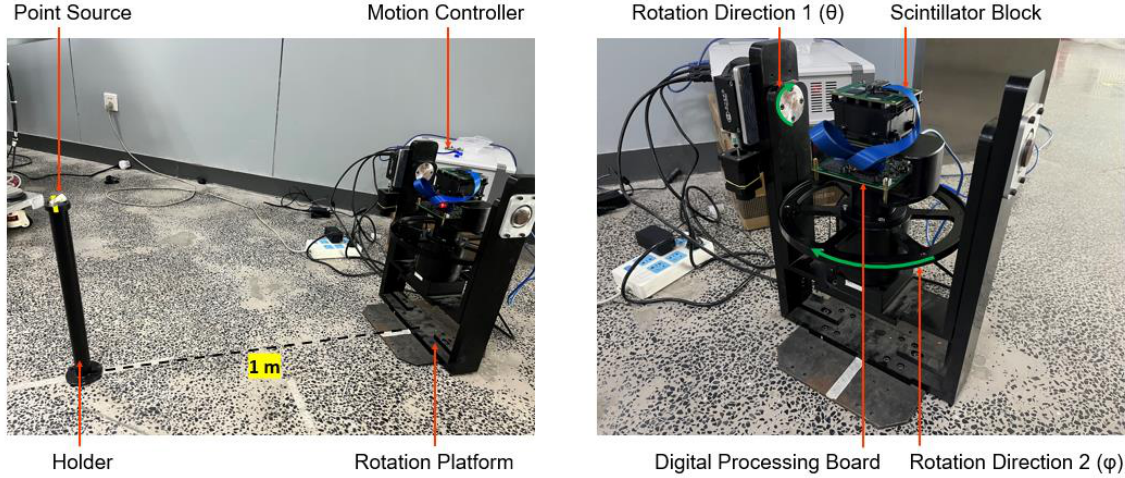
Figure 5. The experimental platform with two rotation axes that accurately control the relative direction between the detector block and the incoming gamma ray from the point source.